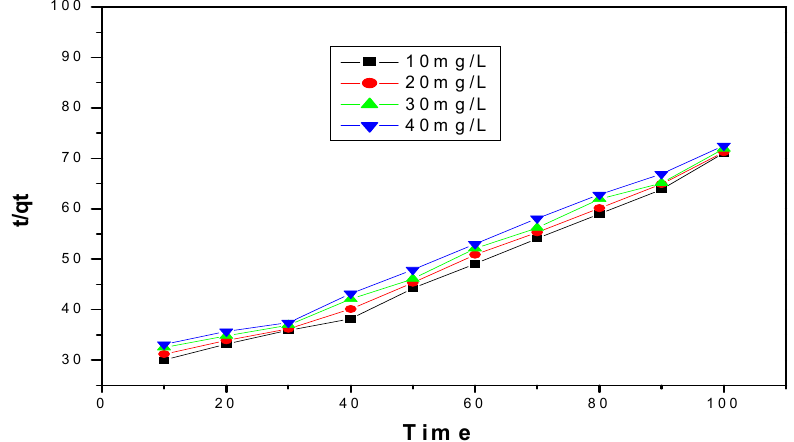
Fig.13.Pseudo-second-order kinetics for Adsorption of Pb(II) ions on magnetic Nanoadsorbent Table